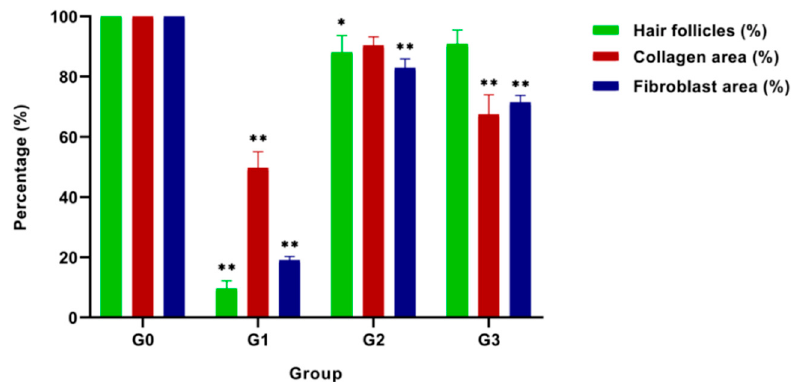
Figure 6. Quantification percentage of hair follicles, area of collagen, and fibroblast cells of healed wound section on day 18 post-surgery. The G0, G1, G2, and G3 represent Group 0 (normal skin tissue), Group 1 (Control), Group 2 (treatment with Palmitoyl-GDPH), and Group 3 (treatment with tetracycline), respectively. Data are displayed as mean ± SD obtained from triplicate experiments. The asterisks (*) represent significant difference (* p < 0.05) and very significant difference (** p < 0.01) from positive control (normal skin group; Group 0).